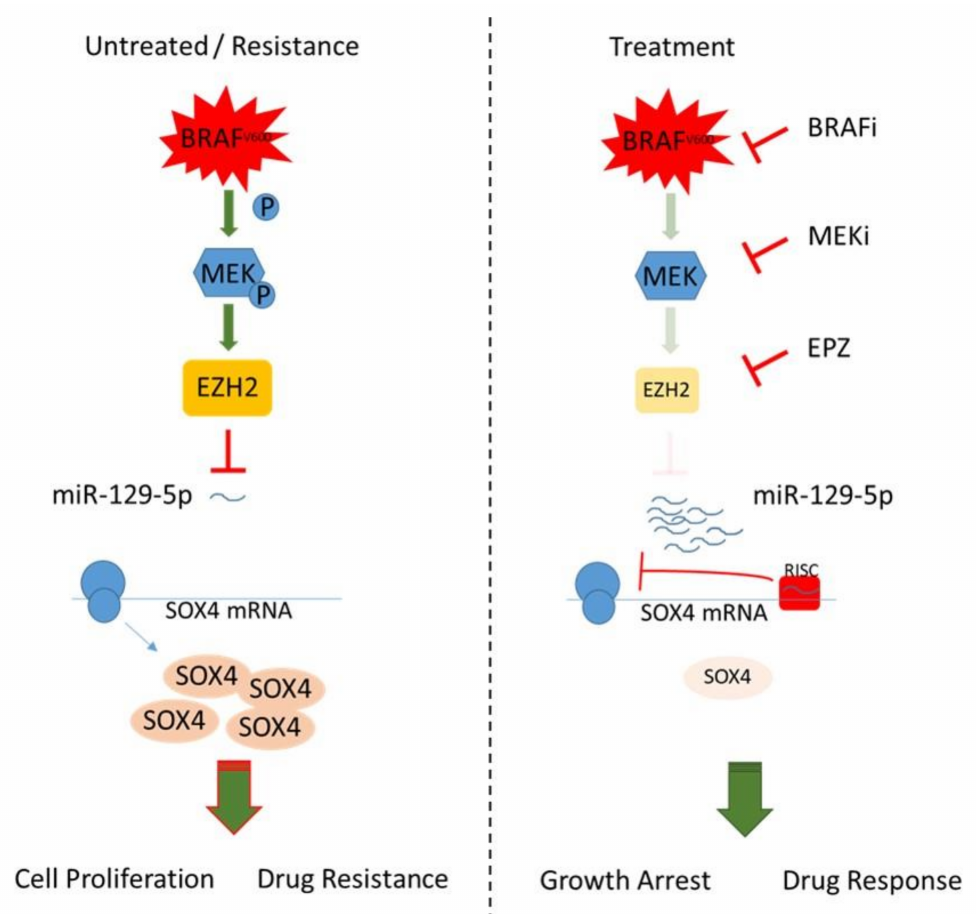
Figure 6. BRAF/EZH2 signaling represses miR-129-5p inhibition of SOX4 thereby modulating BRAFi resistance in